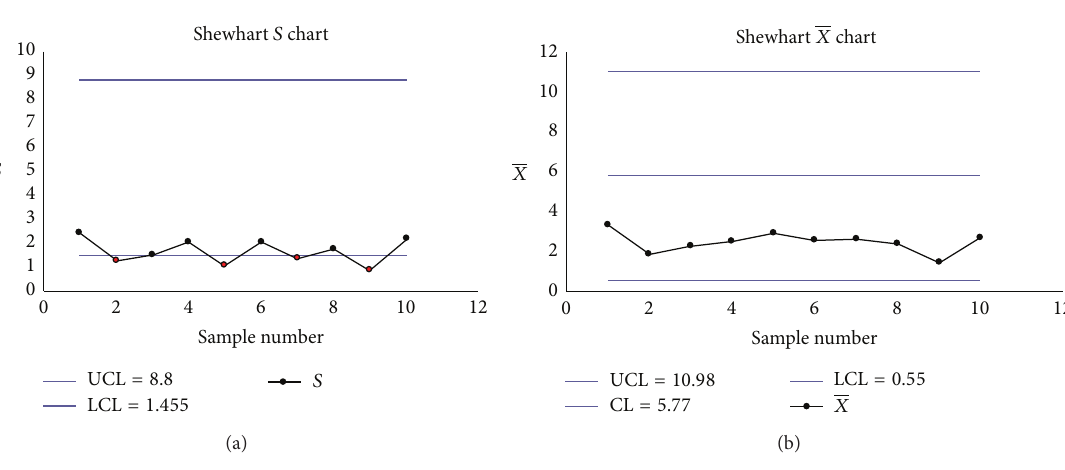
Figure 6: (a) The Shewhart 𝑆 chart. (b) The Shewhart 𝑋